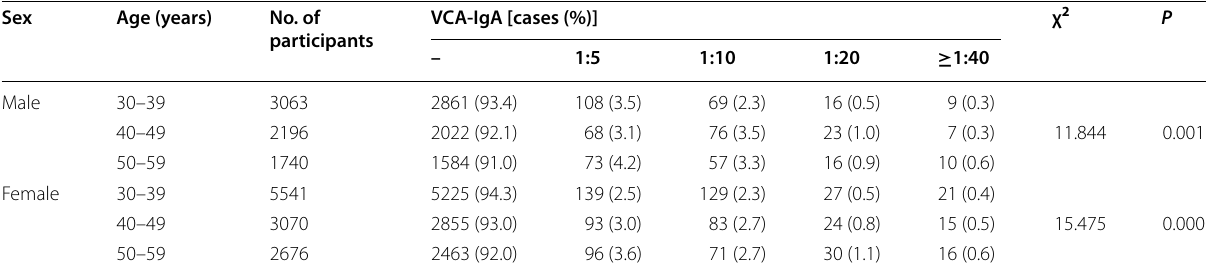
Table 1 Baseline VCA-IgA distribution in 18,286 non-nasopharyngeal carcinoma (NPC) participants by age and sex